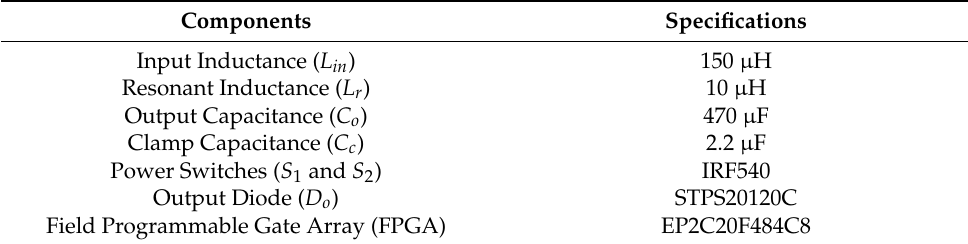
Table 3. Component